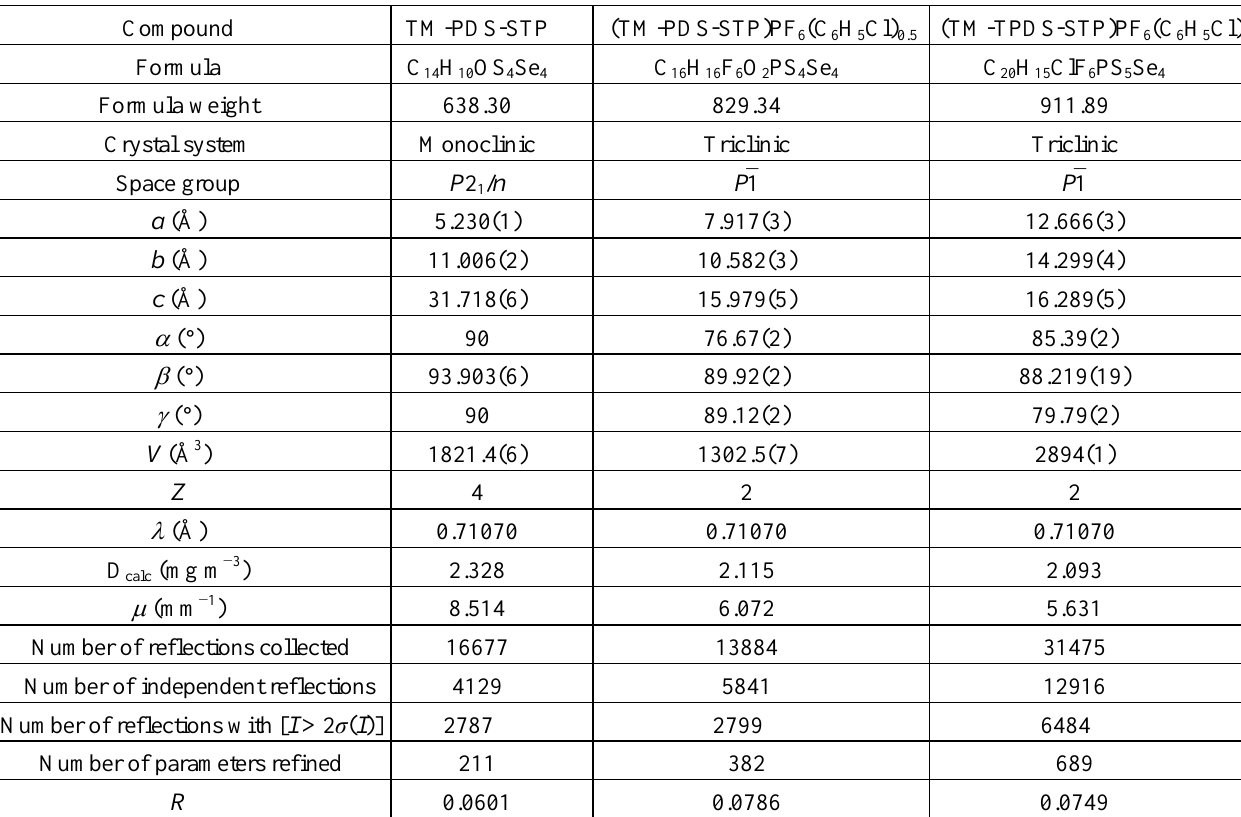
Table 3. Crystal data and structure refinement for TM-PDS-STP,